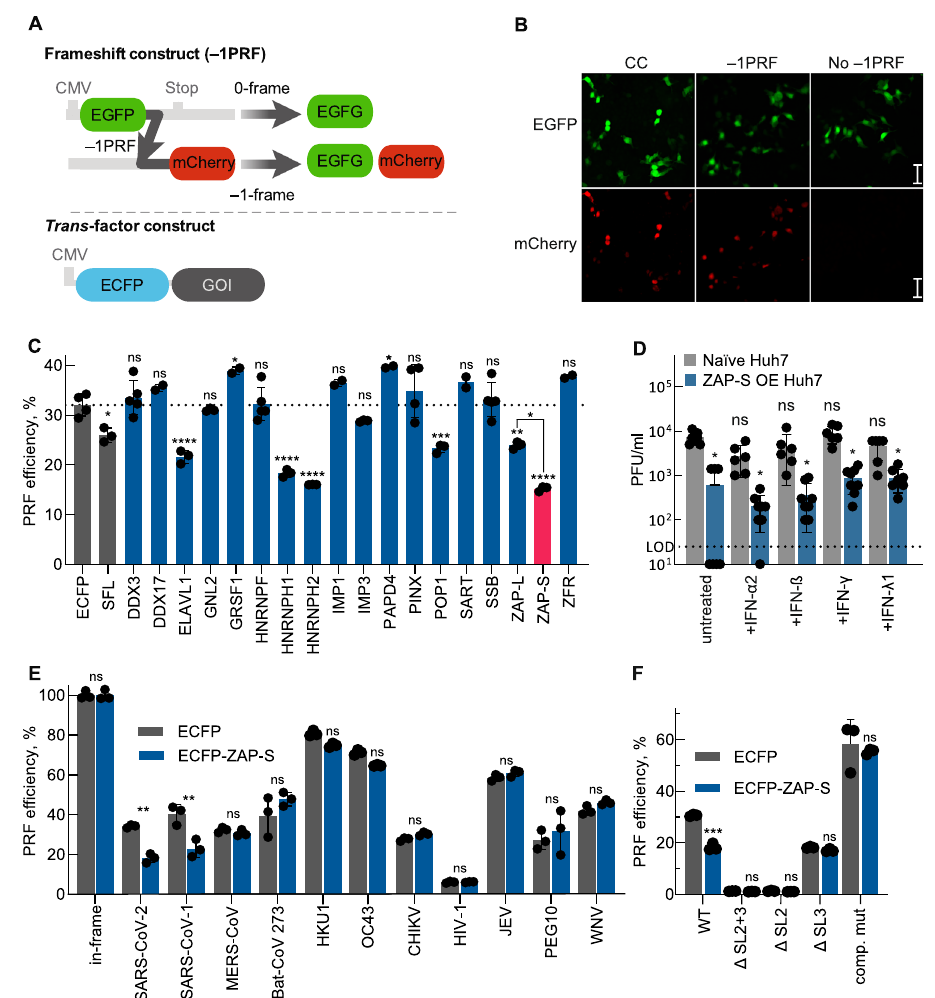
Fig. 2 A functional screen of SARS-CoV-2 – 1PRF element interactors. A Schematic representation of the dual- fl uorescence frameshift reporter construct. EGFP and mCherry are separated by a self-cleaving 2 A peptide as well as by a stop codon in-frame with EGFP. As a result, 0-frame translation would produce only EGFP, whereas – 1PRF would produce both EGFP and mCherry. The ratio of mCherry to EGFP fl uorescence is used to quantify the FE. The trans -factor construct is an N-terminal fusion of ECFP with the protein of interest to be analyzed. The control construct consists of ECFP alone. B Confocal microscopy images of cells transfected with the EGFP-mCherry control (CC- no – 1PRF site included after EGFP and mCherry in-frame with EGFP), – 1PRF, and no PRF (no – 1PRF site and stop codon after EGFP) constructs. The size bar represents 50 µ m. n = 1 independent experiment. C Comparison of relative FE of cells overexpressing trans -factors as ECFP fusion proteins. Data points represent the mean ± s.d. ( n = 3 independent experiments). P values were calculated using an ordinary unpaired one-sided ANOVA comparing every condition to the ECFP control. ZAP-L and ZAP-S were separately compared to each other. * P < 0.05, ** P < 0.01, *** P < 0.001, **** P < 0.0001. Exact P values: SFL – 0.03, DDX3 – 0.99, DDX17 – 0.72, ELAVL1 – < 0.0001, GNL2 – 0.99,